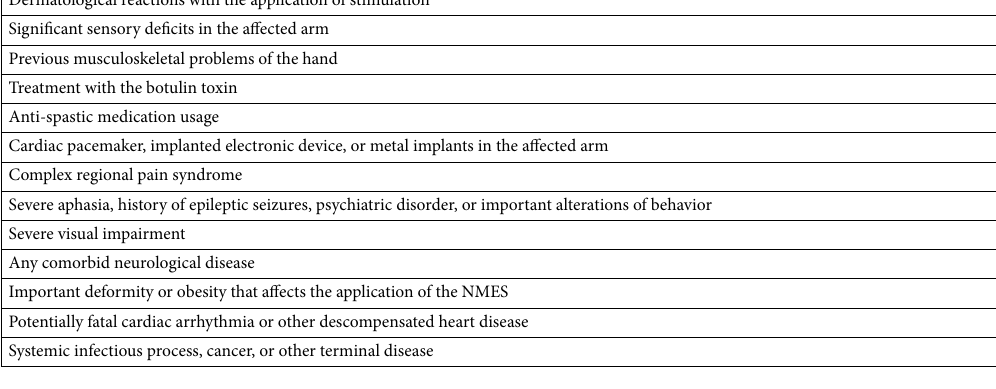
Table 7. Exclusion